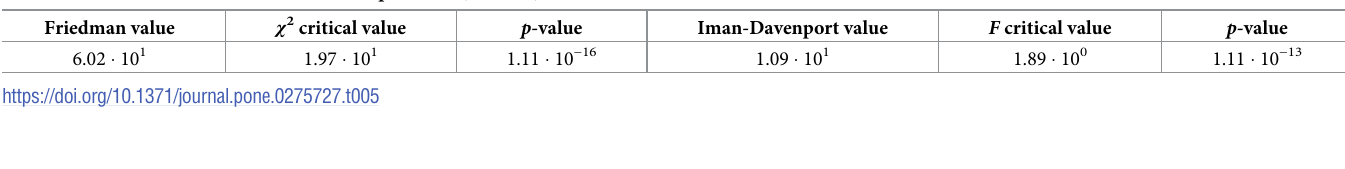
Table 5. Resilts of Friedman and Iman-Davenport tests ( α =